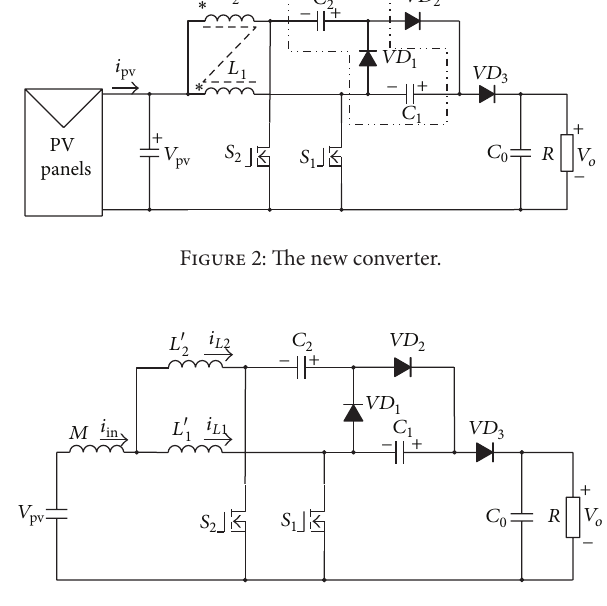
Figure 3: Equivalent circuit of the new